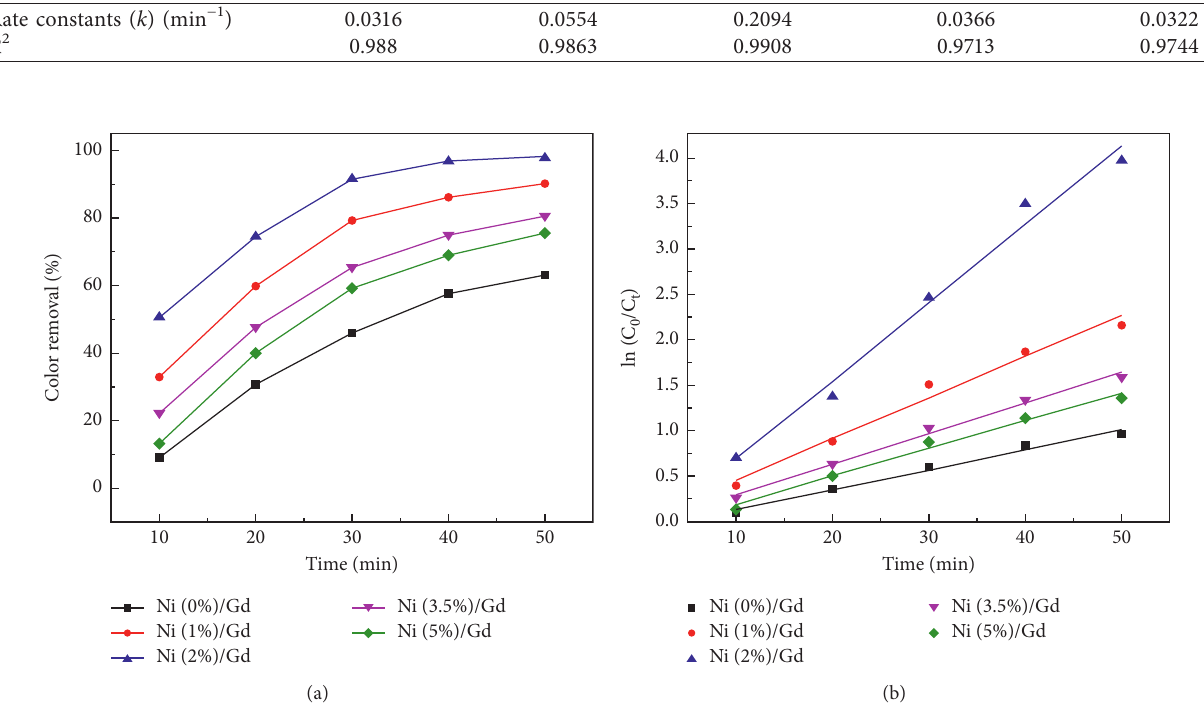
Figure 8: Electrochemical decolorization performance at Ti/SnO 2 -Sb-Ni/Gd electrodes modified with various Ni contents. (a) Decol- orization efficiency. (b) Kinetic analysis of the curves (RhB concentration: 40mg L − 1 ; current density: 10mAcm − 2 ; supporting electrolyte: 0.1molL − 1 Na 2 SO 4 ; 25 °